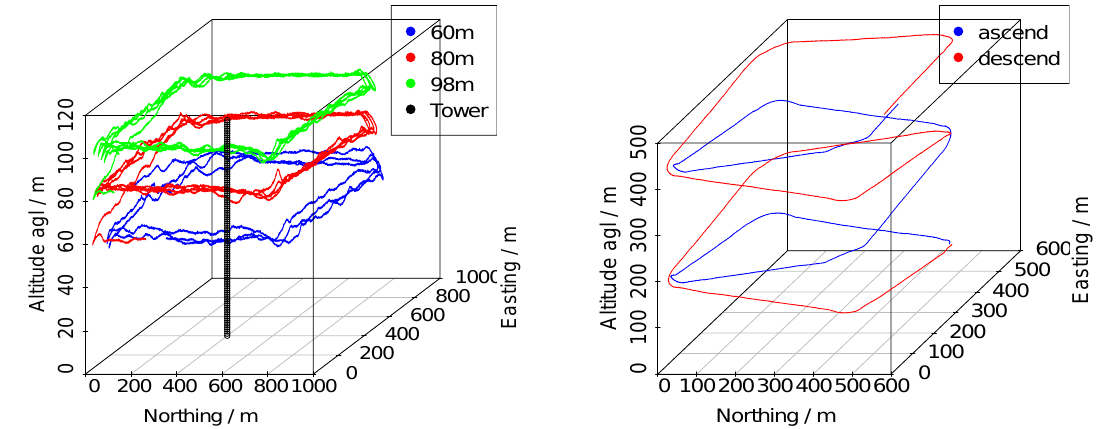
Fig. 7. Flight paths for tower sweep maneuver (left panel) and vertical profiles (right panel). The solid black vertical line represents the measurement